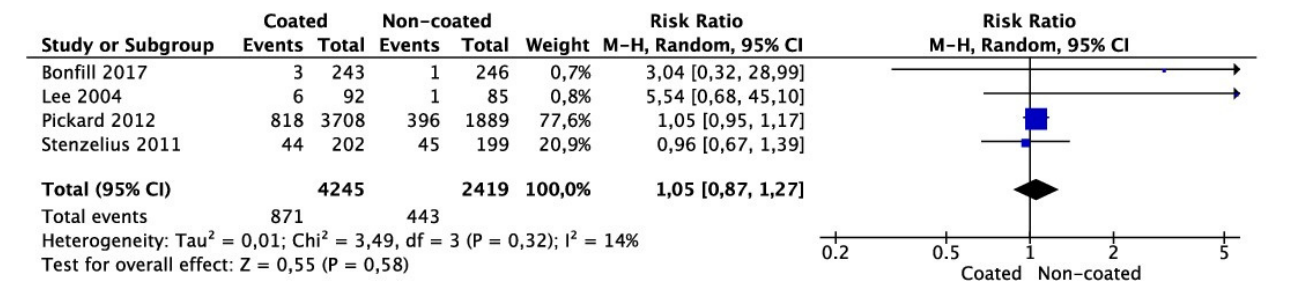
Figure 4. Meta-analysis of need for removal/change of catheter.